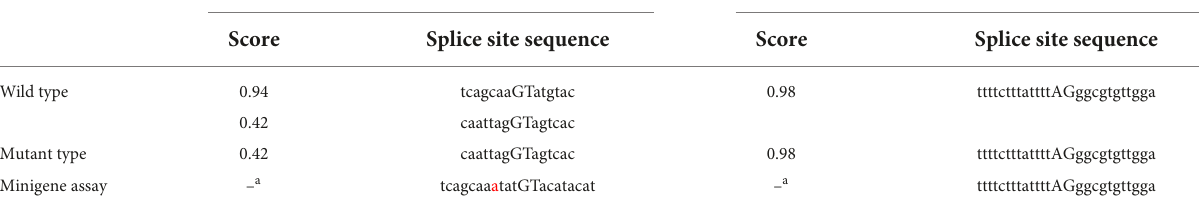
TABLE 2 Results of BDGP and minigene